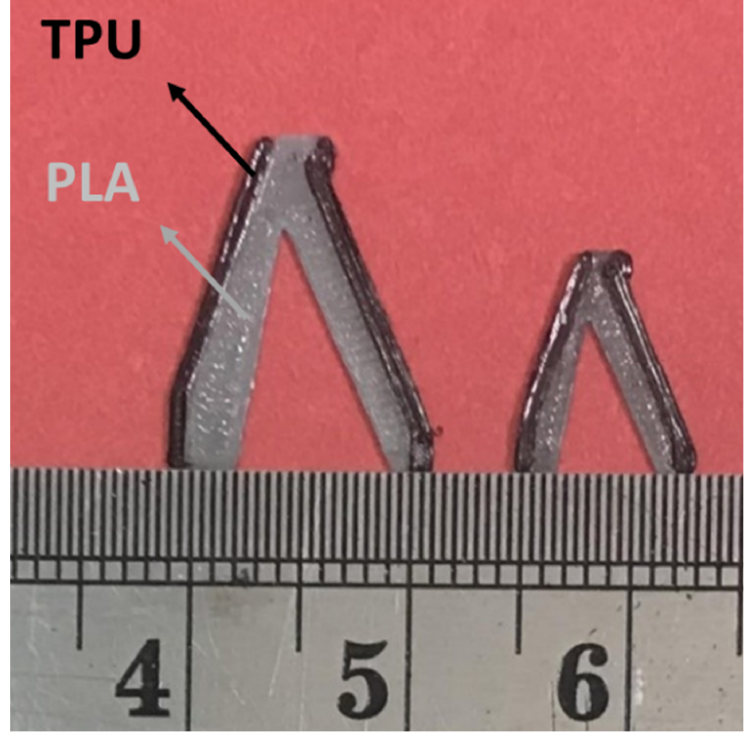
Figure 10. The bi-material metamaterial cells made by FDM 3D